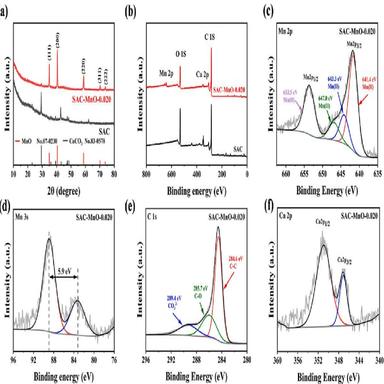
(a) XRD patterns of SAC and SAC-MnO-0.020; (b) XPS spectra of SAC and SAC-MnO-0.020; High-resolution XPS spectrum of (c) Mn 2p, (d) Mn 3s, (e) C 1s and (f) Ca 2p of SAC-MnO-0.020.